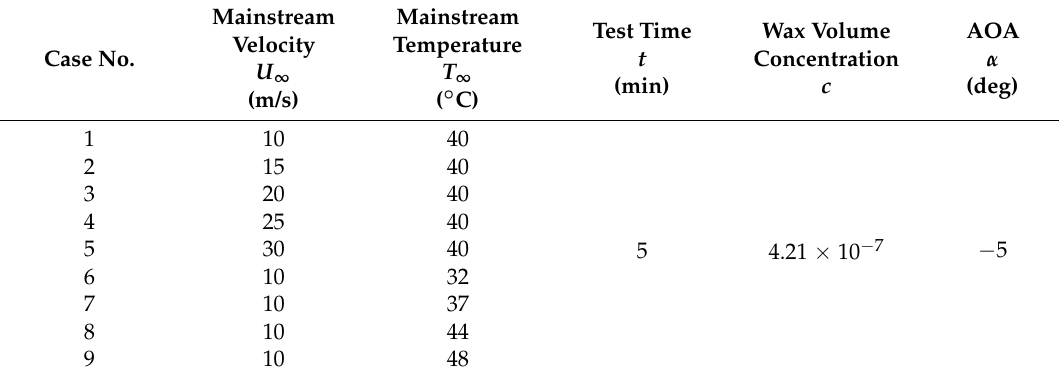
Figure 7. Wax particle size distribution. Table 3. Test parameters for deposition testing.